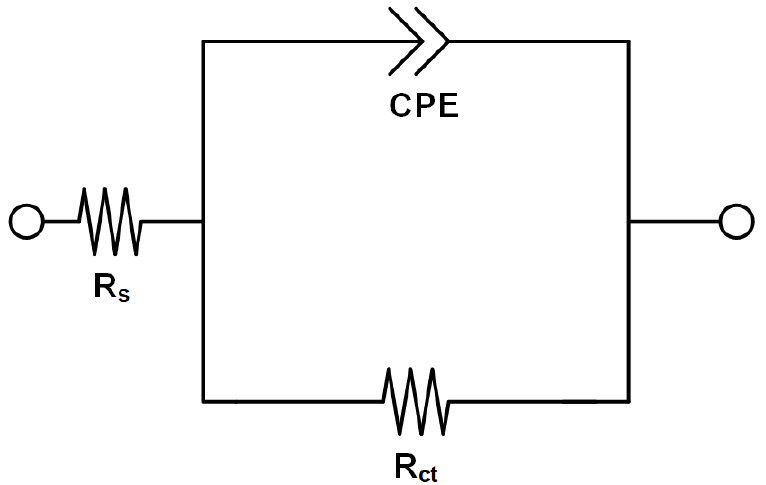
Figure 4. Electrical equivalent circuit for EIS tests. Table 3. Parameters extracted from the EIS data of SPPS-38 carbon steel weldment in the deaerated district heating water containing different concentrations of imidazole at 60 °C .